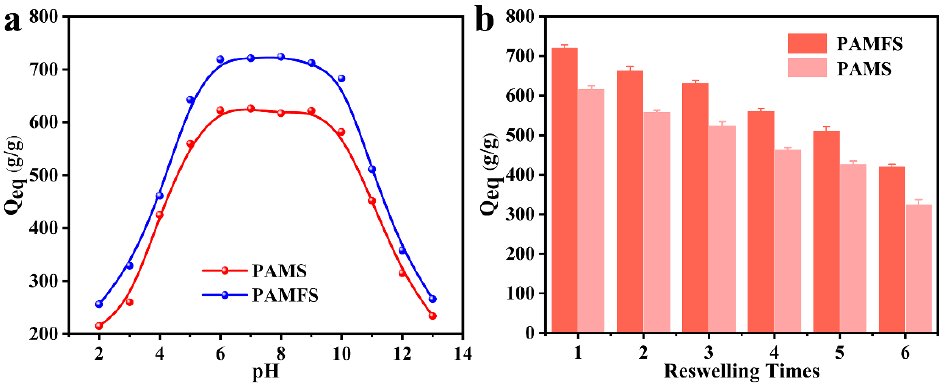
Figure 5. Effects of pH on the water absorbency of PAMFS and PAMS ( a ), water absorbency of PAMFS and PAMS prepared as a function of re-swelling times ( b ).